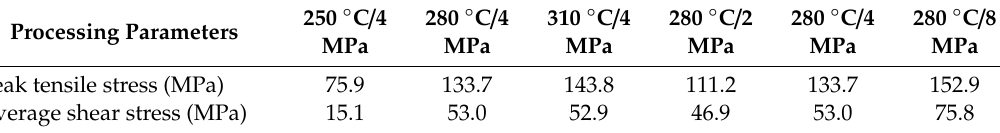
Figure 9. Tensile stress versus engineering strain curves for PA66–PP interface under various processing parameters: ( a ) melting temperatures and ( b ) injection pressure.